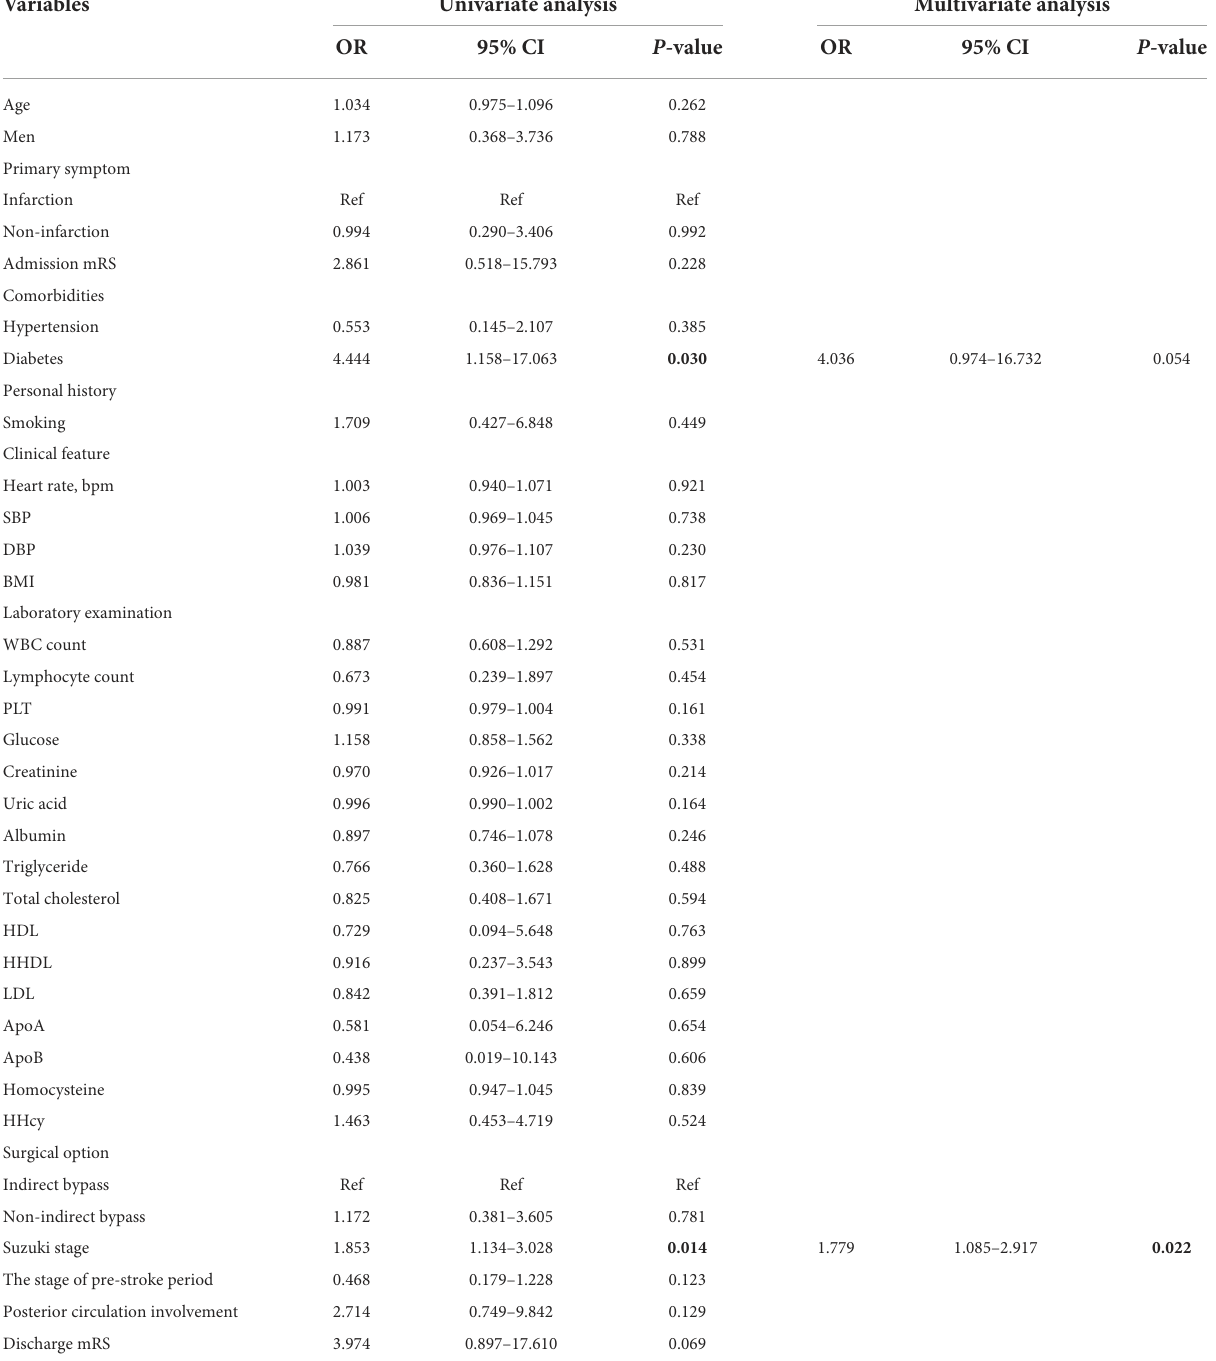
TABLE 4 Univariate and multivariate logistic analysis for neurological